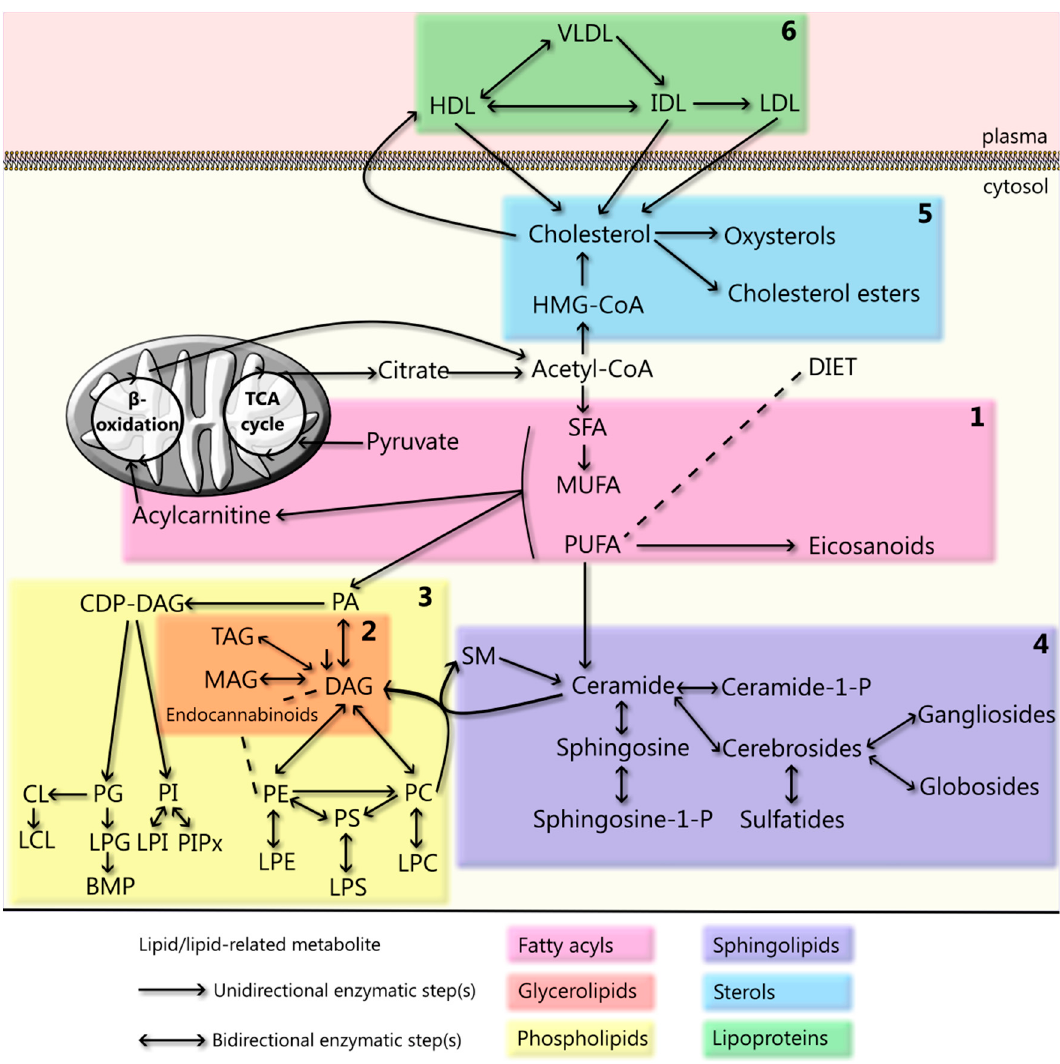
Figure 1. Cellular lipid metabolism and lipoprotein cycle. Schematic representation of lipid metabolism, whereby each colored box represents one lipid class: ( 1 ) fatty acyls, which include saturated (SFA), monounsaturated (MUFA), and polyunsaturated (PUFA) fatty acids, their mitochondrial-transporter, acylcarnitine, and the PUFA-derivatives eicosanoids; ( 2 ) glycyerolipids, including monoacylglycerol (MAG), diacylglycerol (DAG), and triacylglycerol (TAG), together with endocannabinoids (even though only some of them belong to this lipid class); ( 3 ) phospholipids, which include phosphatidic acid (PA), phosphatidylcholine (PC), phosphatidylserine (PS), phosphatidylethanolamine (PE), phosphatidylinositol (PI), phosphatidylglycerol (PG), cardiolipin (CL), and their lyso derivatives (lysoPC (LPC), lysoPS (LPS), lysoPE (LPE), lysoPI (LPI), lysoPG (LPG) and lysoCL (LCL)), and Bis(monoacylglycero)phosphate (BMP); ( 4 ) sphingolipids, including ceramide(-1-phosphate), sphingosine(-1-phosphate), sphingomyelin (SM), cerebrosides, sulfatides, gangliosides, and globosides; ( 5 ) sterols, which include the metabolites of cholesterol synthesis, such as β -hydroxy β -methylglutaryl-CoA (HMG-CoA), cholesterol, and its derivatives cholesterol esters and oxysterols; and ( 6 ) lipoproteins, including high-density lipoproteins (HDL), intermediate-density lipoproteins (IDL), low-density lipoproteins (LDL), and very low-density lipoproteins (VLDL). A depiction of the various lipid structures and of all the metabolic steps involved in their generation and interconversion(s) is given in Figures 2a,b–6a,b, respectively.